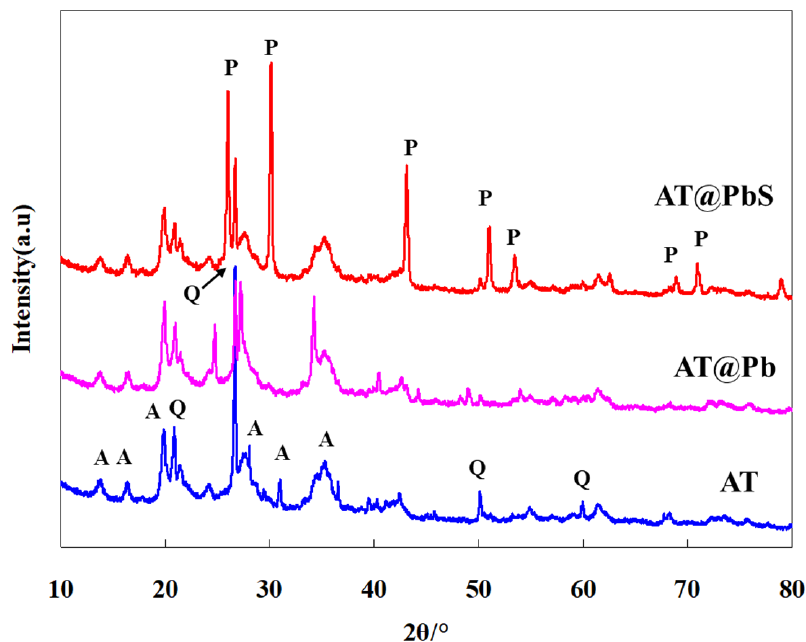
Figure 2. XRD (X-ray diffraction) patterns of AT (attapulgite), AT@Pb (Pb-adsorbed saturated attapulgite), and AT@PbS (attapulgite/lead sulphide composite ) .